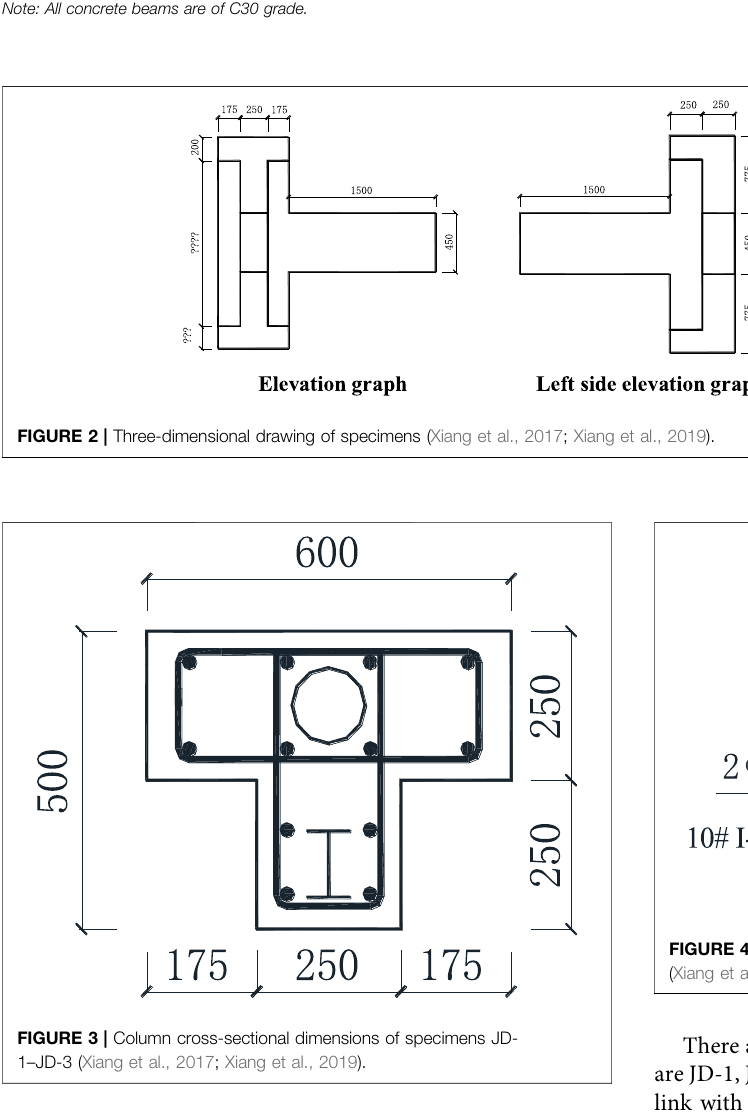
Figure 2 . The column cross-sectional dimensions and cross-